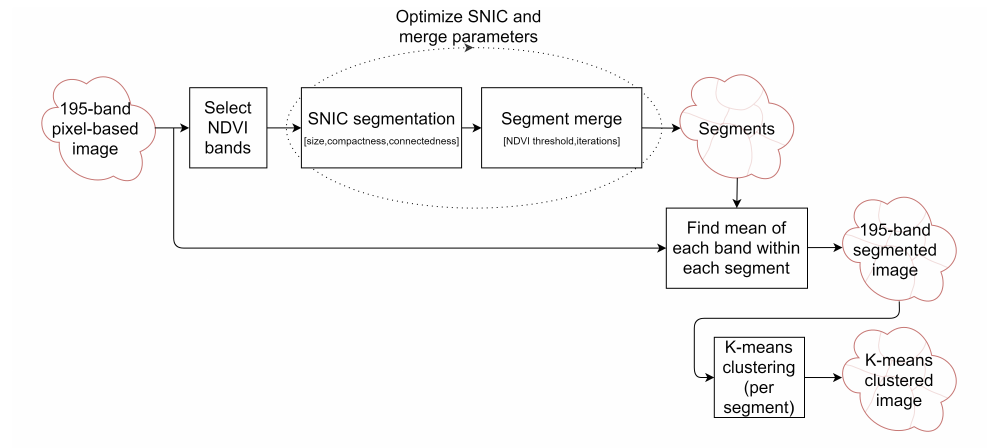
Figure 3. Finding optimum parameters for segment generation, and using the segments to create segmented and K-means cluster